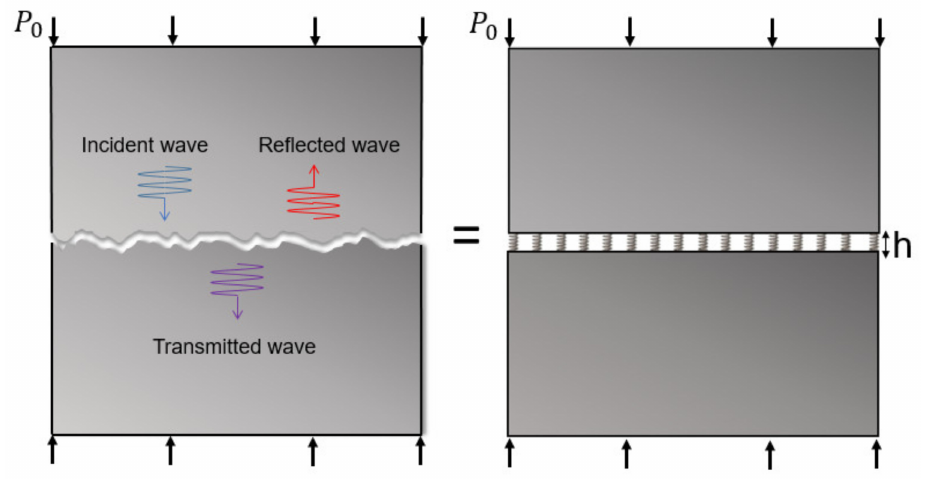
Figure 1. One-dimensional longitudinal plane wave propagation through a rough contact interface and soft contact model of an